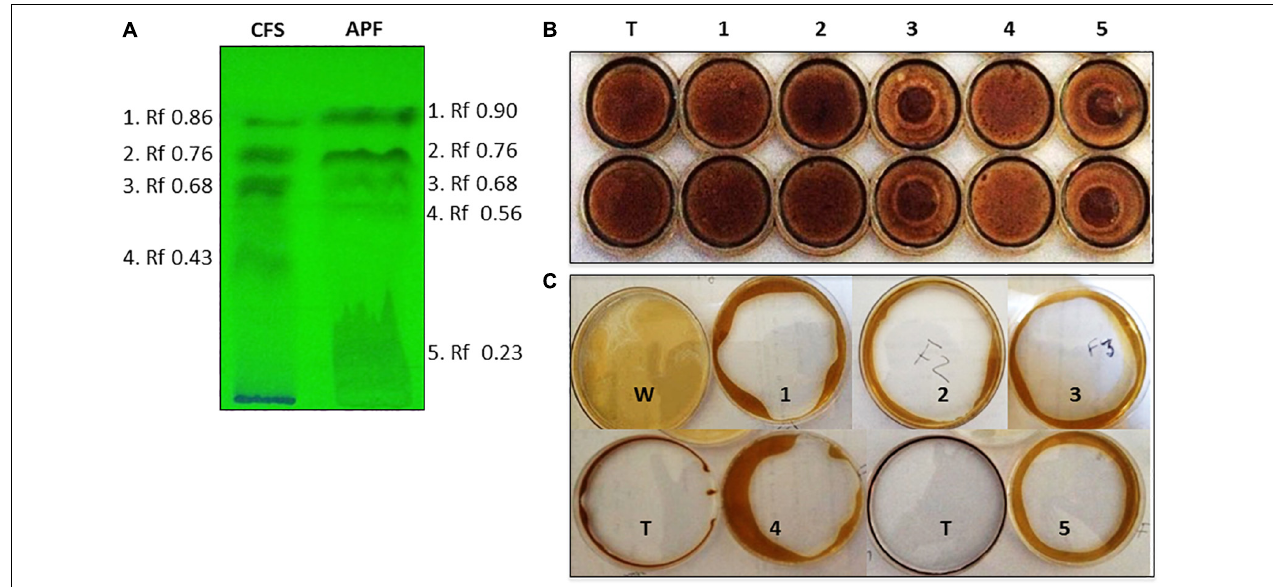
FIGURE 3 | Thin layer chromatography (TLC) separation and biosurfactant assessment of CFS and APF extracts from B. methylotrophicus OB9. (A) TLC plate exposed to UV light with fraction numbers and Rf values denoted for crude (CFS) and acid precipitate (APF) preparations. The biosurfactant properties of TLC-isolated APF fractions of B. methylotrophicus OB9 were analyzed by the drop collapse assay (B) with APF fractions 1-5 and Triton X-100 (T) as a control and the oil spreading assay (C) with APF fractions 1-5, water (W) and Triton X-100 (T).